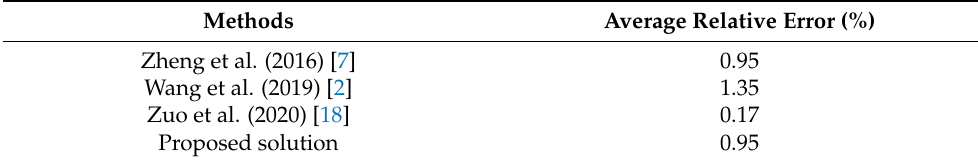
Table 3. Average relative error for state-of-the-art methods.